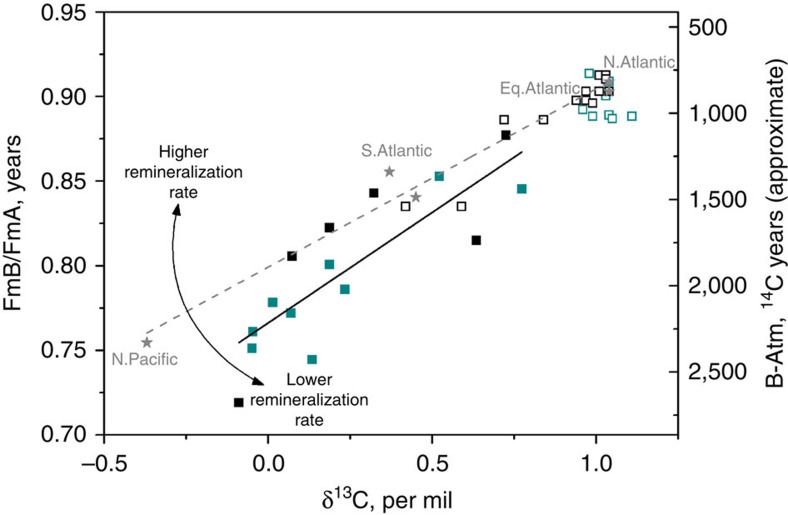
Crossplot of ventilation age and stable carbon isotopic ratio.Ventilation ages are plotted as FmB/FmA, where FmB/FmA=exp(B-Atm/-8033), and Fm=fraction modern, because B-Atm ages do not mix linearly due to the exponential decay of radiocarbon. Approximate B-Atm values are shown as a guideline only. Modern whole ocean data (∼2.5 km water depth; grey stars) is show along with modern data for the entire water column >2 km (open squares) on the Iberian Margin (blue) and Brazil Margin (black). LGM data are shown (filled squares) for the Iberian Margin (blue) and the Brazil Margin (black; Modern data are from GEOSECS and GLODAP38). The modern gradient is 0.11±0.01 and the LGM gradient is 0.13±0.02, equivalent to 1.1±0.1‰/kyr and 0.9±0.2‰/kyr in the modern and in the LGM, respectively. For a given rate of remineralization, an increase in residence time (that is, lower FmB/FmA) results in a greater amount of carbon storage.